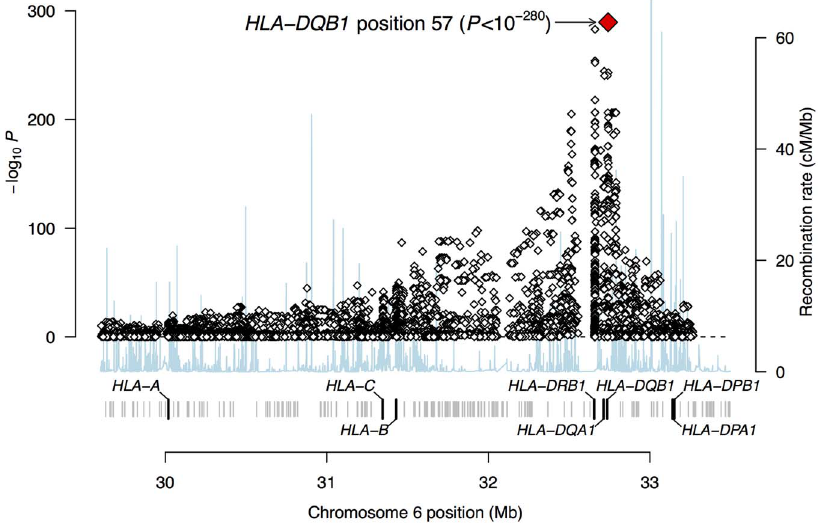
Figure 4. Association analysis of WTCCC type 1 diabetes data. We imputed classical HLA alleles and polymorphic amino acids in 1,963 cases and 2,939 controls using the T1DGC reference panel, and tested all variants for association with logistic regression. Of all variants tested, the top hit maps to amino acid position 57 in HLA-DQ b 1, consistent with a previous study [16].